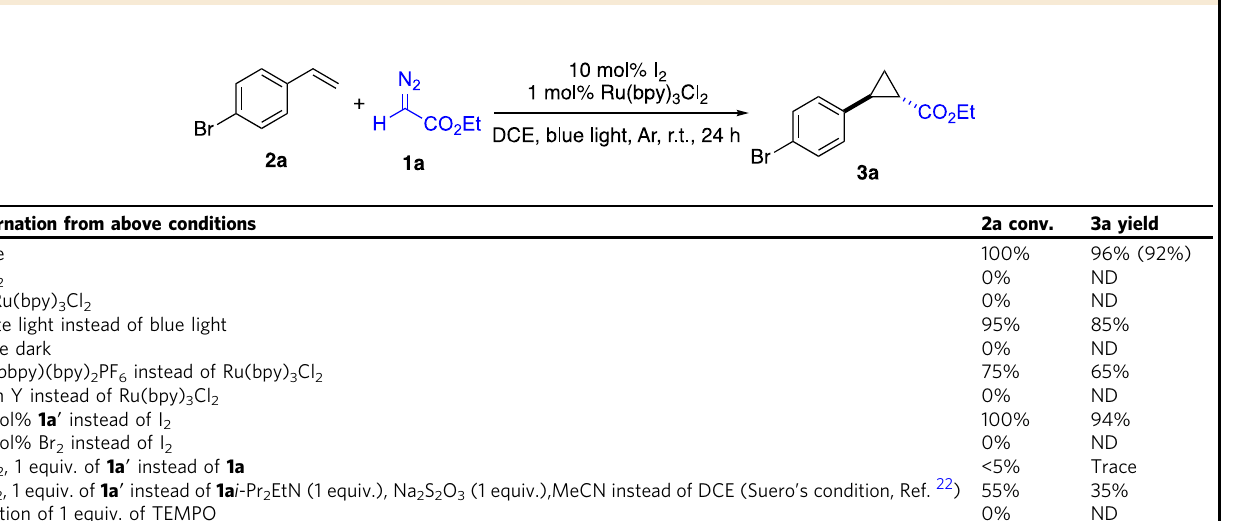
Alternation from above